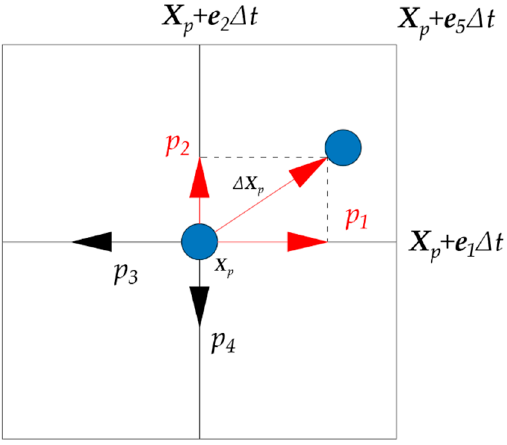
Figure 6. Particle motion diagram in cellular automata probability model.